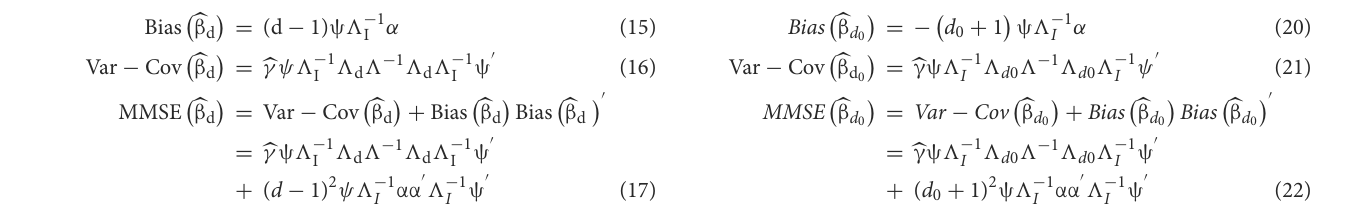
TABLE 2 MSE values in case of p = 3 and γ =